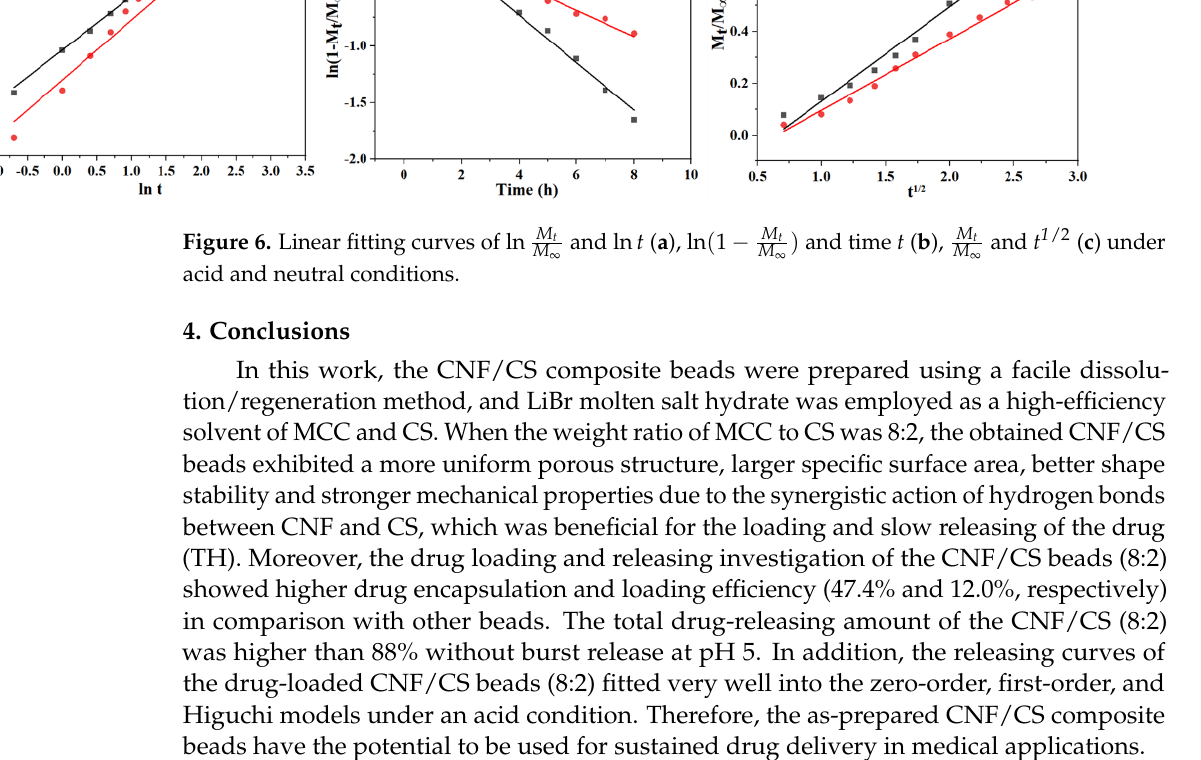
Figure 6. Linear fitting curves of ln acid and neutral conditions.